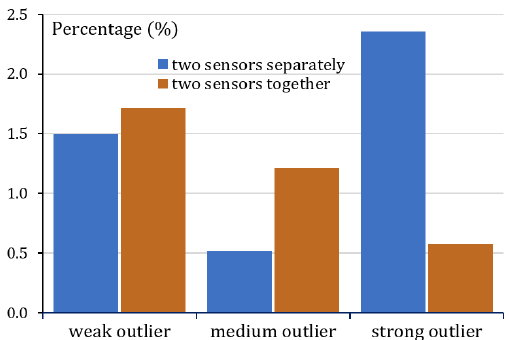
Figure 5. Percentage of classes of outliers (weak, medium, and strong) when analysing measurements from the given time only (blue) and also from the previous time step (brown). Data from